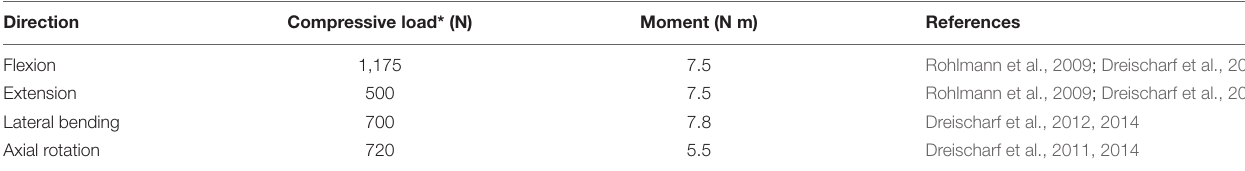
TABLE 2 | Combined loading conditions for simulation of lumbar spine in different movements.